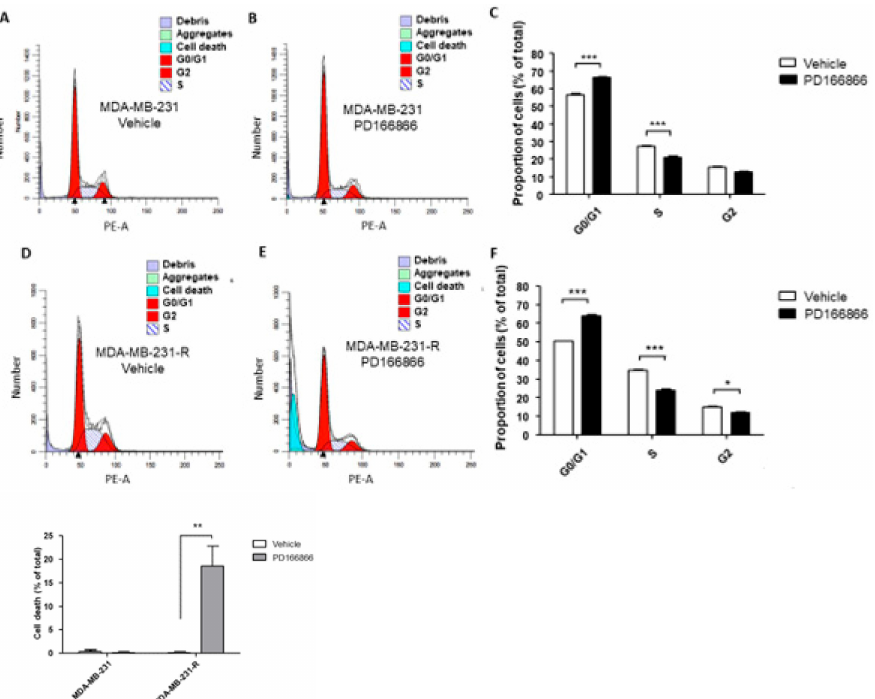
Figure 6. Cell cycle arrest in MDA-MB-231 and MDA-MB-231-R cells treated with PD166866. Cells were treated with 10 µ M PD166866 or vehicle in complete medium for 72 h, fixed, stained with propidium iodide and cell cycle analysis performed by flow cytometry. Shown are representative flow cytometry histograms of MDA-MB-231 ( A , B ) and MDA-MB-231-R ( D , E ) cells. Shown in the bar graphs are the calculated proportions of cells at different cell cycle phases for MDA-MB-231 ( C ) and MDA-MB-231-R cells ( F ) and in ( G ) the proportions of dead cells for each cell type. Results are based on three independent experiments and are expressed as mean percentage ( ± SE) of total cells in ( C , F ) and percent of all events analyzed in ( G ). * p < 0.05, ** p < 0.01, *** p < 0.001.